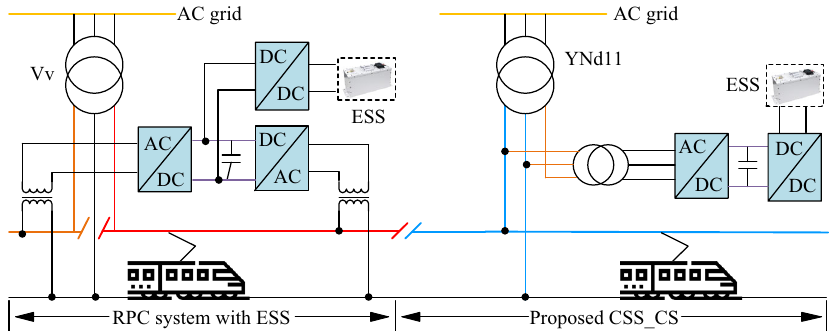
Fig. 2 Topology of CSS_SC and RPC